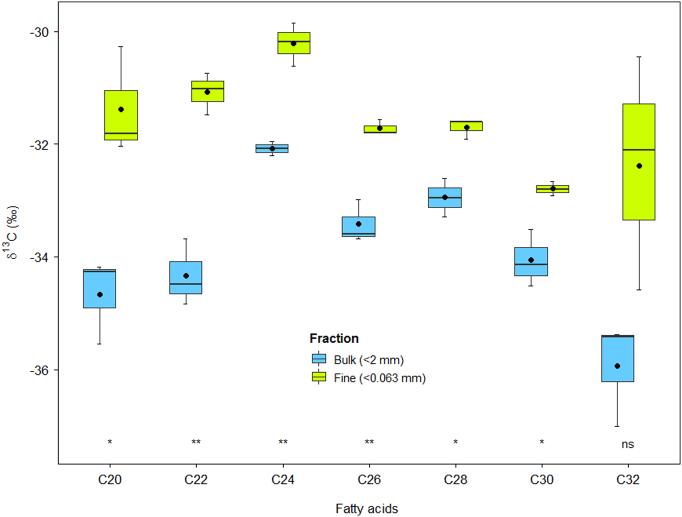
Distribution of isotopic composition of long-chain FAs in the bulk and fine fractions of the time-integrated suspended sediment samples. Asterisks indicate significant differences (ns, p > 0.05; *p < 0.05; **p < 0.01) between fractions of FAs. Horizontal line and closed circle in the box indicate median and mean values respectively. The bottom and top of the box refer to the 25th and 75th percentile i.e. interquartile ranges (IQR) and whiskers represent the smallest and largest values within 1.5 times of the IQR.